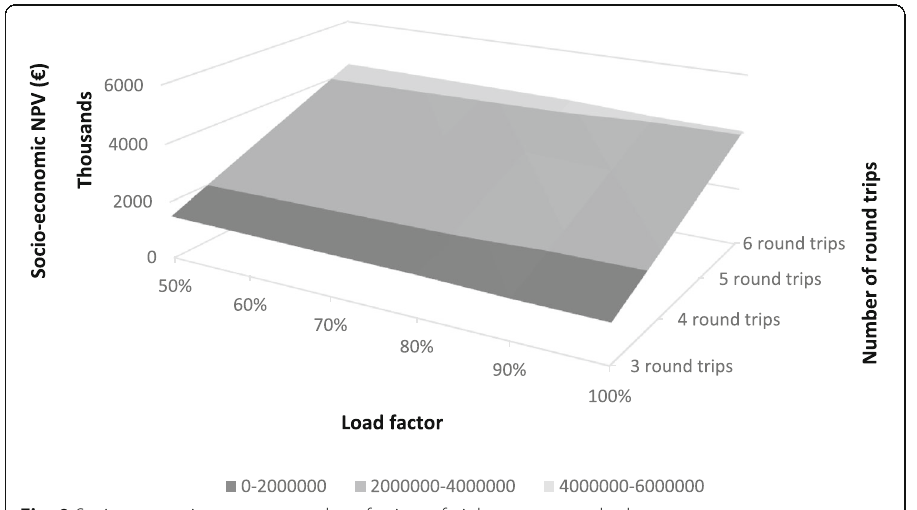
Fig. 9 Socio-economic net present value of using a freight wagon attached to a passenger